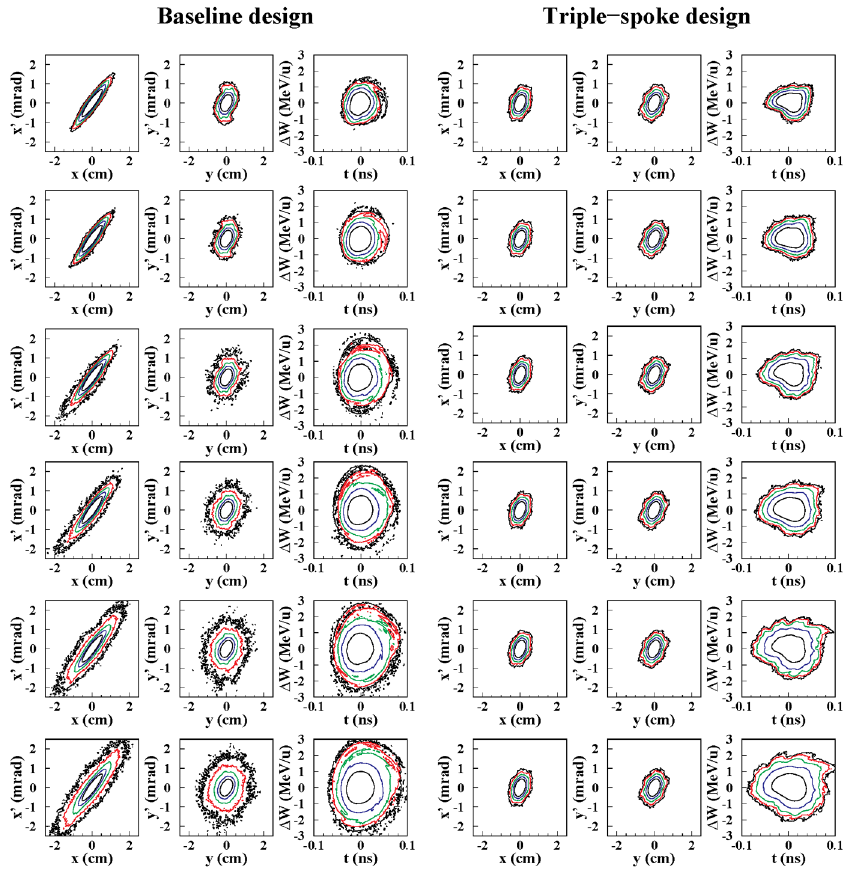
FIG. 13. (Color) Phase-space plots for both accelerator designs and the error combinations of Table II. The plots are for combination 1 (top) to combination 6 (bottom), respectively. The logarithmic density isolines are represented by different